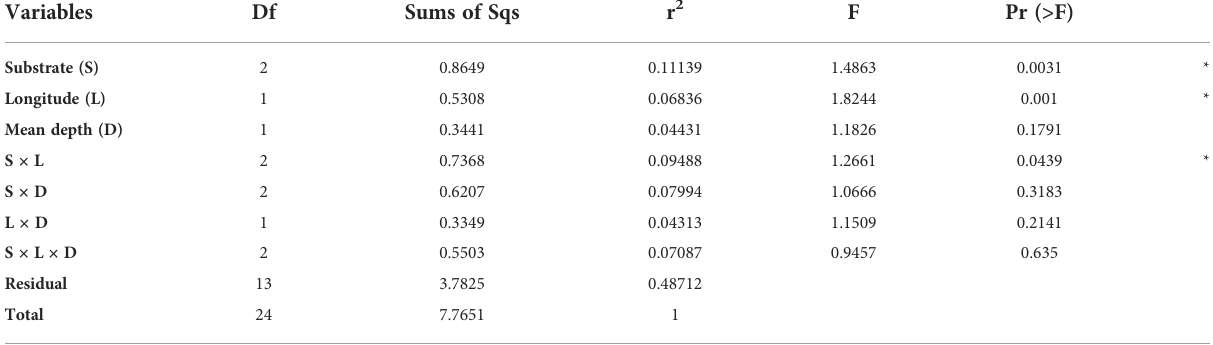
TABLE 2 Results of three way PERMANOVA modelling, including qualitative (substrate) and numerical variables (longitude and mean depth). Variables Df Sums of Sqs r 2 F Pr (>F) Substrate (S) 2 0.8649 Longitude (L)